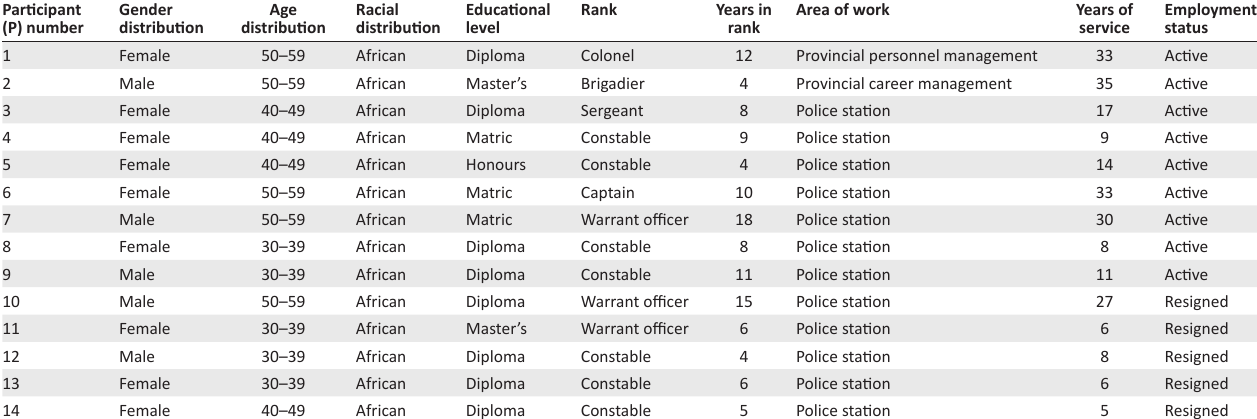
TABLE 1: Demographic profile of respondents. Participant Gender (P) number